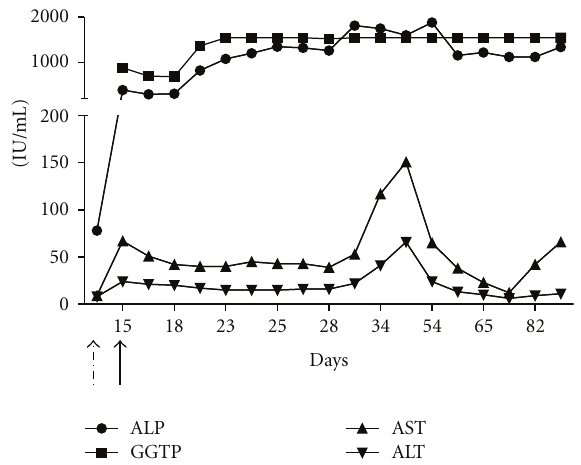
Figure 1: Elevation of AST, ALT, GGTP, and ALP following nafcillin treatment (day 1 marked as dashed arrow). Undashed straight arrow marks the day of nafcillin withdrawal (day